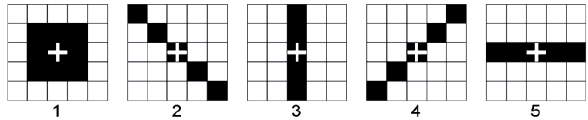
Figure 4. Candidate neighbourhoods for adaptive MRF.